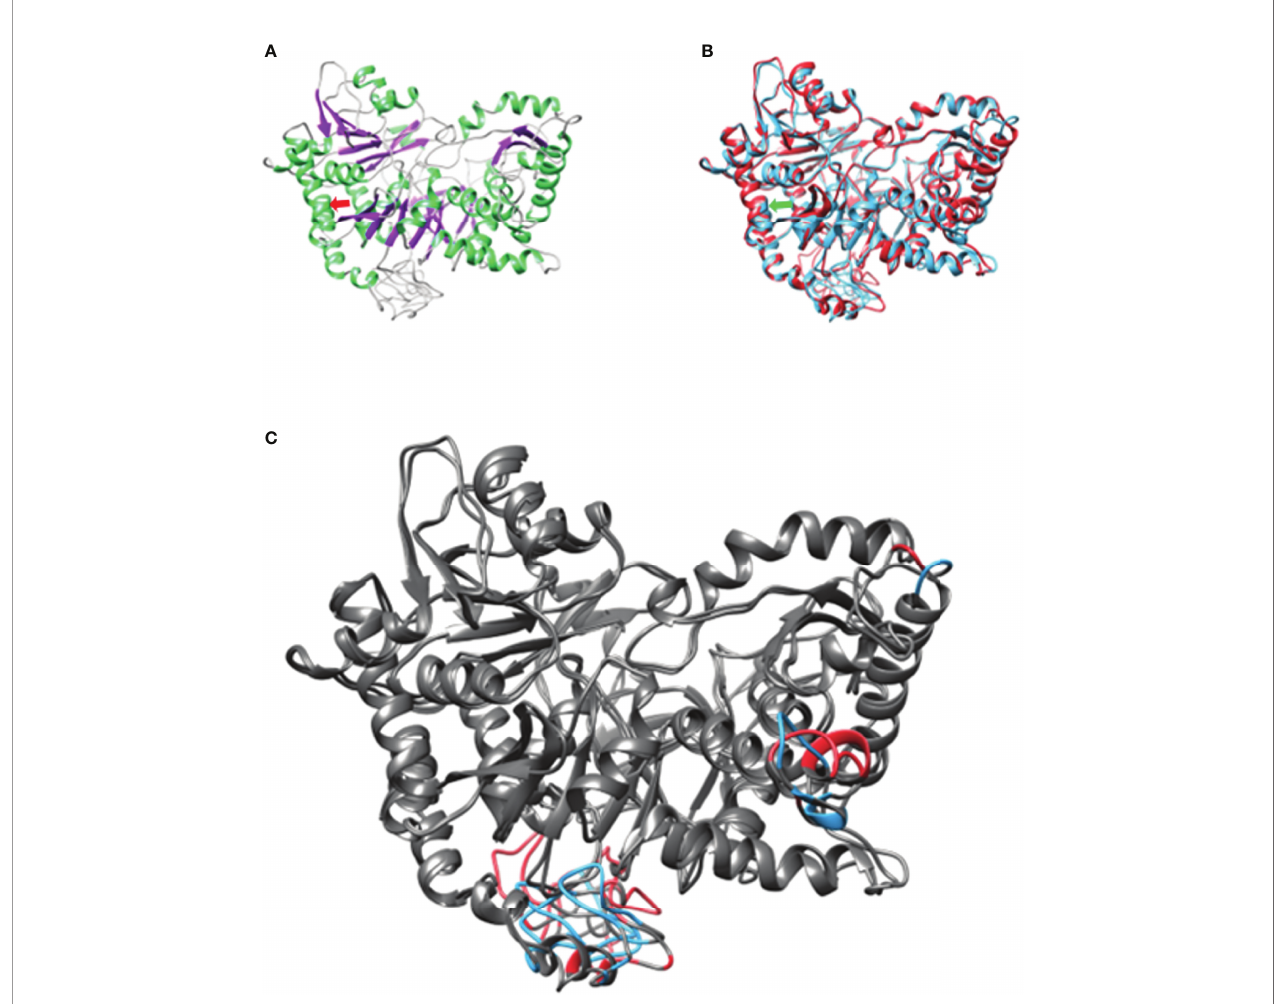
FIGURE 2 | Structural conformation and pairing of ACSL6. (A) Weight isoform with secondary structure coloring. On the light green a -helices, on the purple b -sheet and the coils. (B) Structural alignment of both models. In both arrows they represent the point where the amino acid change occurs. (C) Differences representing 21.5%. dissimilarity. At the bottom, the transmembrane domain. In gray structural agreements between